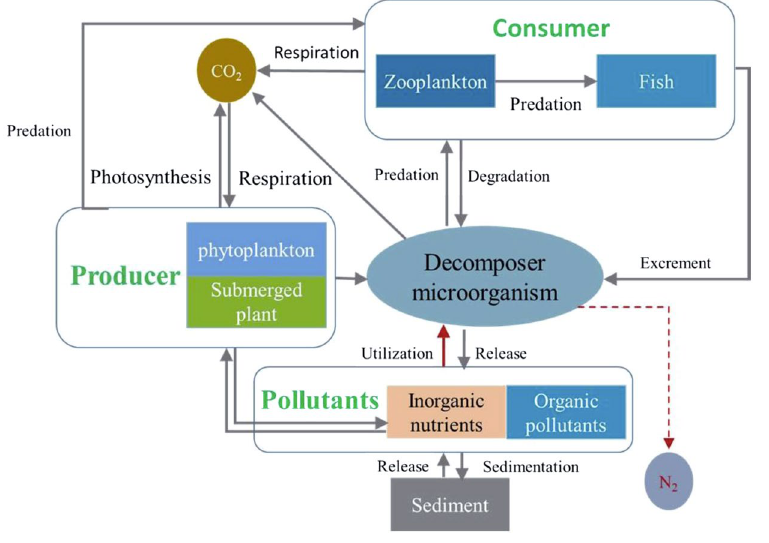
Figure 1. Proposed mechanism of